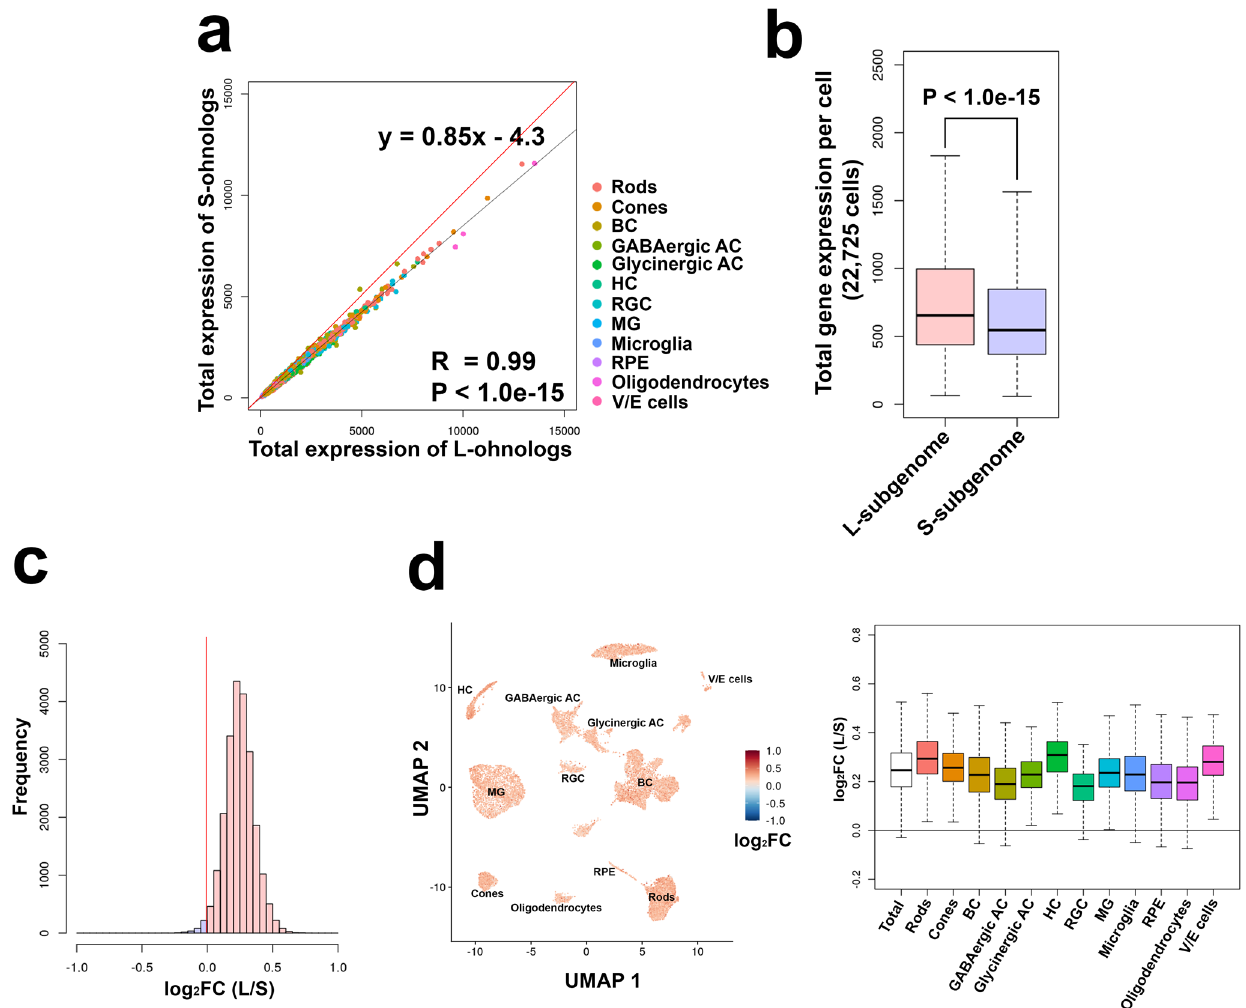
Fig. 2 Expression bias toward the L-ohnolog over the S-ohnolog in gold fi sh retinal cells. a Scatter plot of the total gene expression of L-ohnologs and S-ohnologs in cells. The x axis indicates the total gene expression of L-ohnologs and the y axis indicates that of S-ohnologs. The dots are colored according to cell types. The total gene expression of L-ohnologs and S-ohnologs showed a positive and signi fi cant correlation (Pearson ’ s correlation coef fi cient = 0.99, P < 1.0e – 15). The red line indicates y = x . b Boxplots of the total gene expression of L-ohnologs and S-ohnologs in cells. The median of the total gene expression of L-ohnologs was signi fi cantly higher than that of S-ohnologs ( P < 1.0e – 15, Wilcoxon test). The ends of the box are the 25 and 75% quantiles. The horizontal line in the box indicates the median. The lines extending from the top and bottom of the box represent the minimum and maximum values. c Distribution of the log2-transformed fold changes of the total gene expression of L-ohnologs and that of S-ohnologs in all 22,725 cells. Values higher than 0 (L-ohnolog > S-ohnolog) are colored in red, and values lower than 0 (L-ohnolog < S-ohnolog) are colored in blue. The red line indicates x = 0. d Distribution of the log2-transformed fold changes of the total gene expression of L-ohnologs and that of S-ohnologs in each cell type. The left panel represents the UMAP plot showing the log2-transformed fold change of the total gene expression of L-ohnologs and that of S-ohnologs in each cell. Cells colored in red indicate that the total gene expression level of L-ohnologs is higher than that of S-ohnolog, whereas the cells colored in blue show the opposite outcome. The right panel represents boxplots of the log2-transformed fold change in the total gene expression of L-ohnologs and S-ohnologs in each cell type. The horizontal line indicates a value of zero. The ends of the box are the 25% and 75% quantiles. The horizontal line in the box indicates the median. The lines extending from the top and bottom of the box represent the minimum and maximum